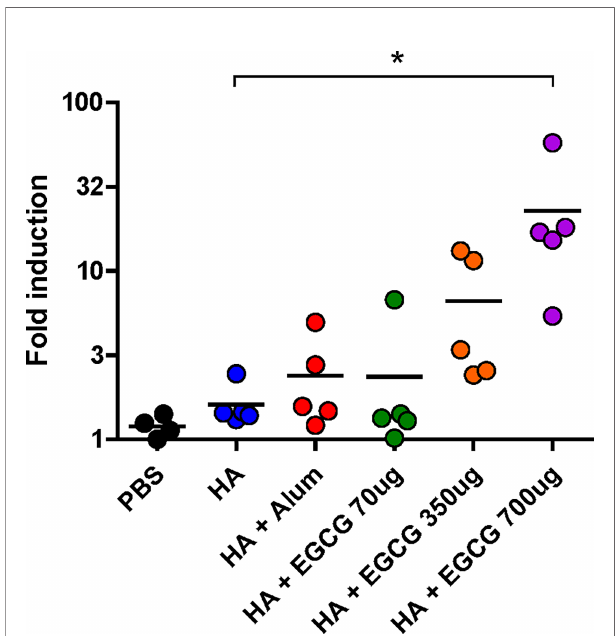
FIGURE 5 | ADCC activity induced by EGCG against PR8 virus. PBS or 7 µg of HA antigens with or without adjuvant (30 m L of alum or 70, 350, or 700 m g of EGCG) were injected into mice thrice every 2 weeks. Sera were collected 2 weeks after the last vaccination. The sera were diluted 100× for the ADCC assay. Fold induction was de fi ned as the increase in responses (number of times) compared to the negative control (reaction without mouse serum). Data are expressed as means (horizontal lines) and scatter plots. One-way ANOVA followed by Tukey ’ s multiple comparison test was conducted to compare three or more groups (* P <